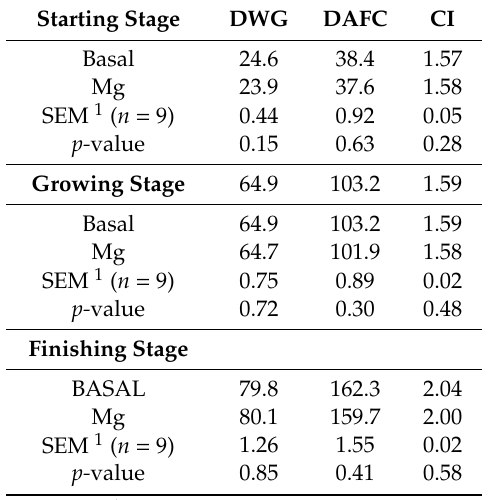
Finishing Stage BASAL 79.8